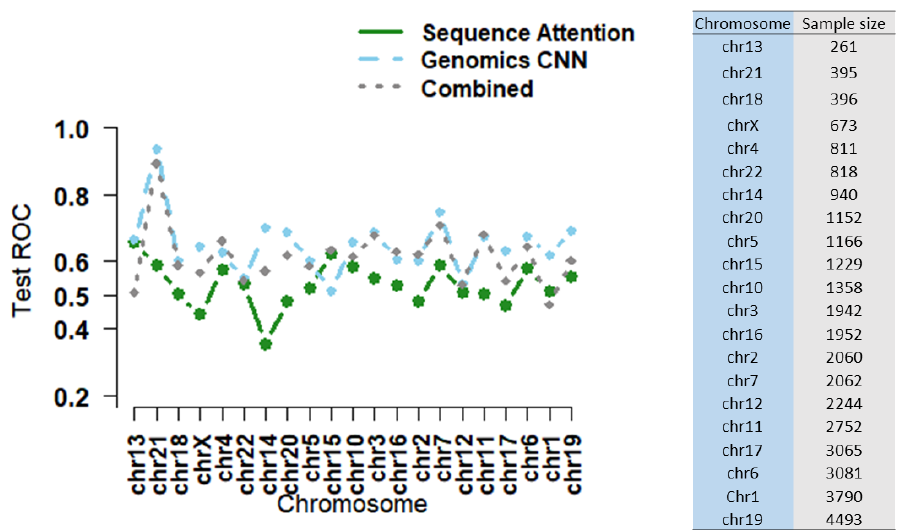
Figure 6. The combined CNN model performance as compared to the sequence and epigenomics CNNs across 21 test chromosomes with the sample size in ascending order.